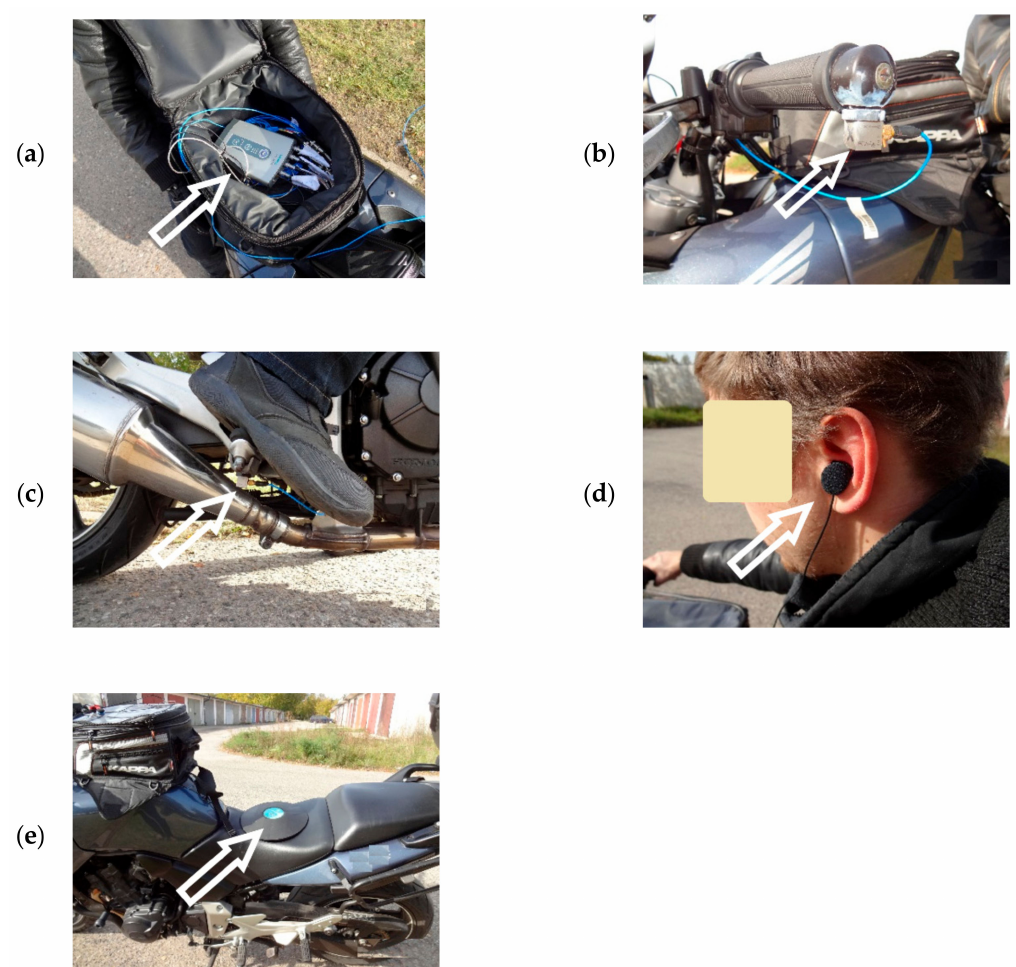
Figure 5. Arrangement of the measuring system’s elements: ( a ) signal recording system, ( b ) three-axis transducer installed on the handlebars of the motorcycle, ( c ) three-axis transducer installed on the footrest of the motorcycle, ( d ) binaural microphone placed in the motorcyclist’s ear, ( e ) measuring pad with a three-axis